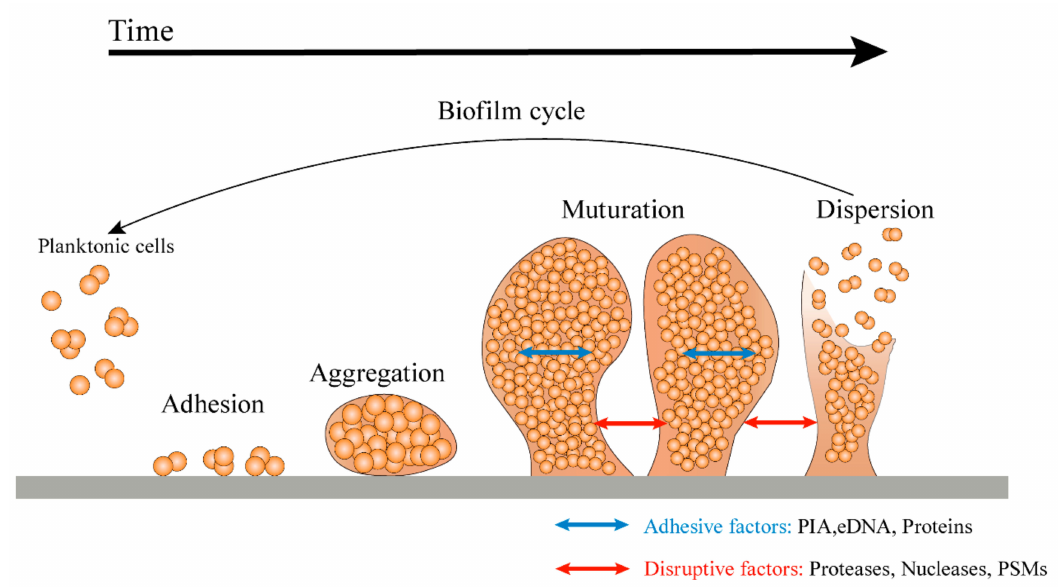
Figure 1. A model of the growth cycle of biofilm. In the first step of biofilm formation, planktonic cells attach to the surface via surface-associated proteins. After attachment, the cells gradually aggregate and begin to produce ECM, thus forming microcolonies. With cell division, a mature biofilm is gradually formed. Finally, in the separation stage, enzymes such as protease, nuclease, and a quorum sensing system promote the dispersion of biofilm, allowing the bacterial cells to detach from the biofilm and return to a planktonic state to colonize new ecological niches